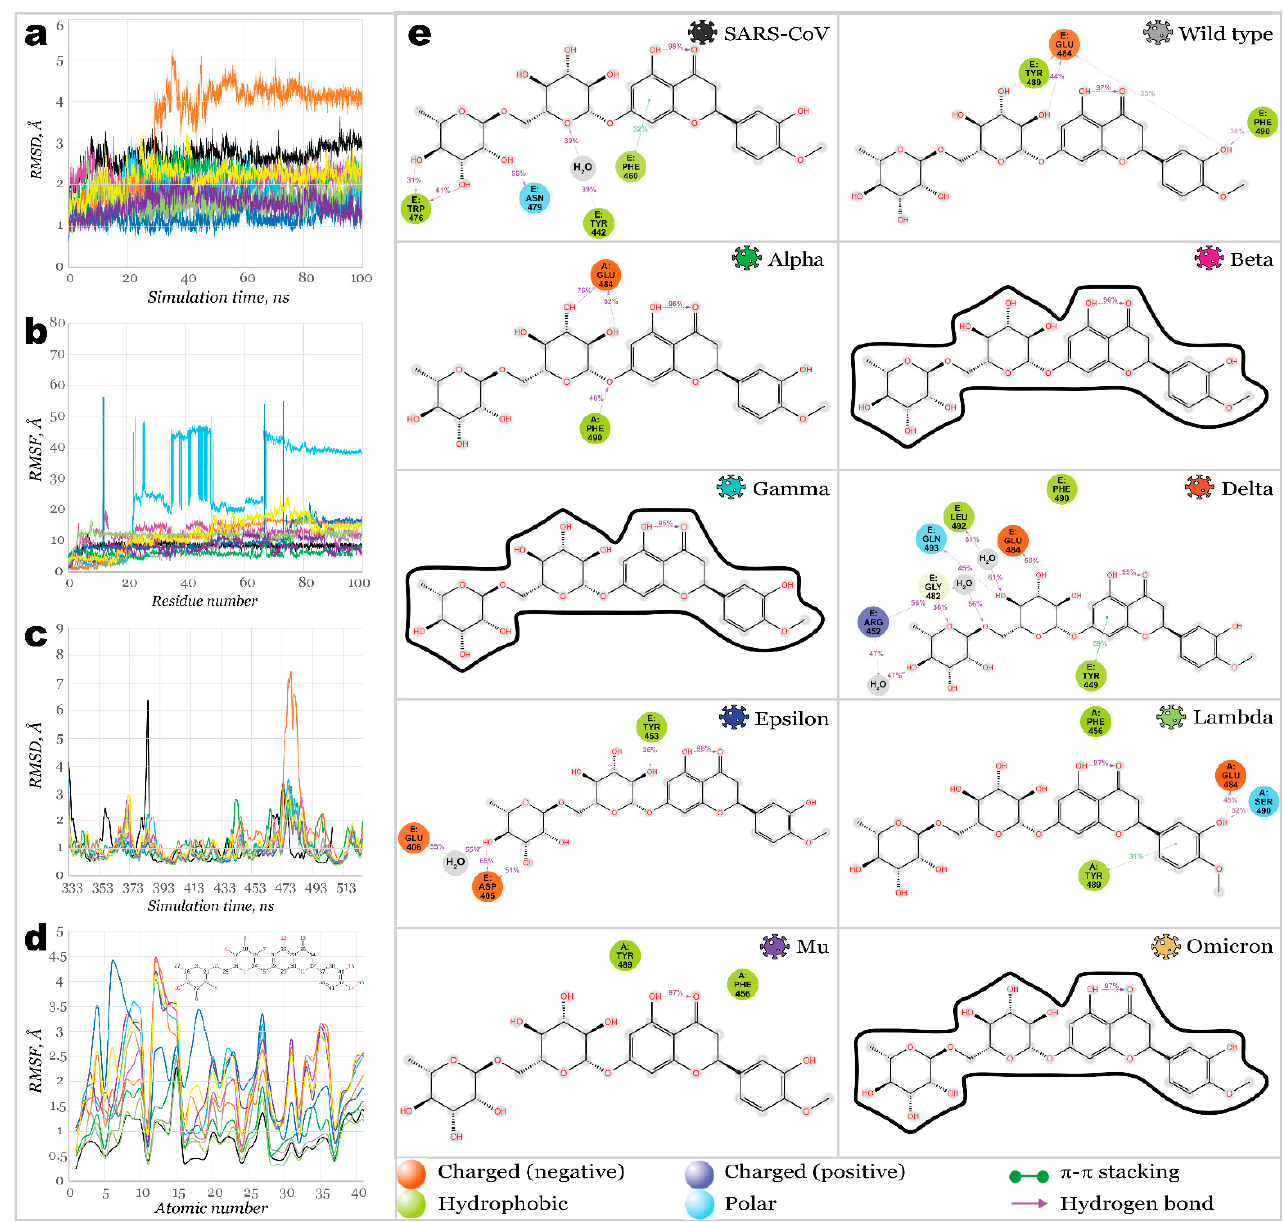
Figure 7. 100 ns MD simulations results for RBD 28 (hesperidin) complexes: ( a )—RMSD of protein’s Ca ; ( b )—RMSF of protein structures; ( c )—RMSD of ligand fit on protein; ( d )—RMSF of ligand’s structures; ( e )—2D interactions diagram for hesperidin and RBDs.